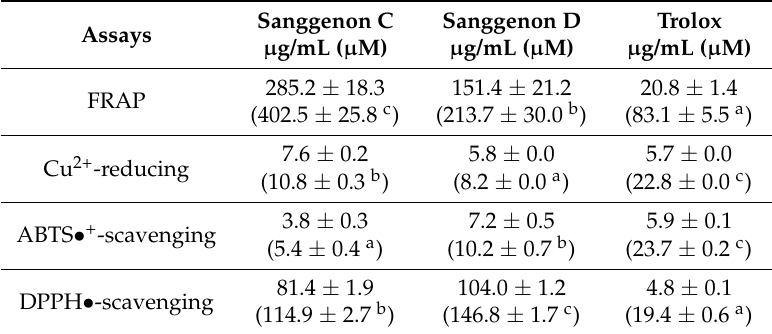
Table 1. The IC 50 values of sanggenons C and D in various antioxidant assays.